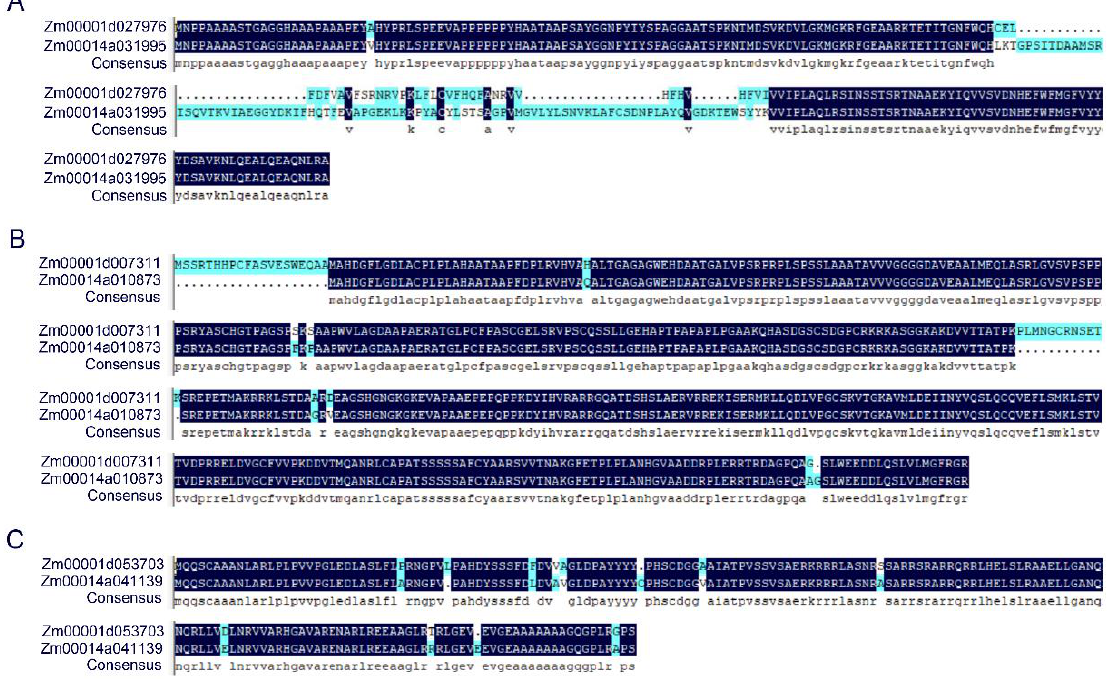
Figure 6. Sequence analysis of candidate genes between B73 and Mo17. Comparison of Zm00001d027976 or Zm00014a031996 ( A ), Zm00001d007311 or Zm00014a010873 ( B ), and Zm00001d053703 or Zm00014a041139 ( C ) amino sequence in B73 or Mo17 genome.